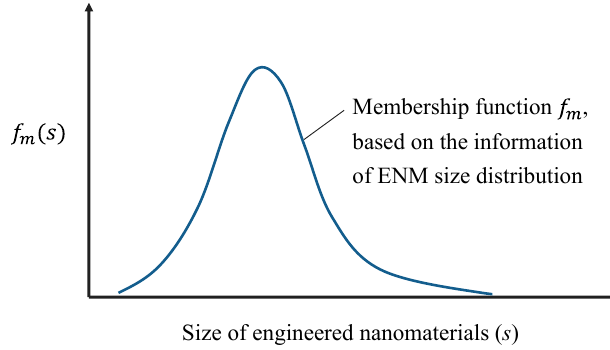
Figure 4. An explanation of considering the fuzzy set theory in handling the heterogeneity of ENM size for the computation of nano-specific descriptors.